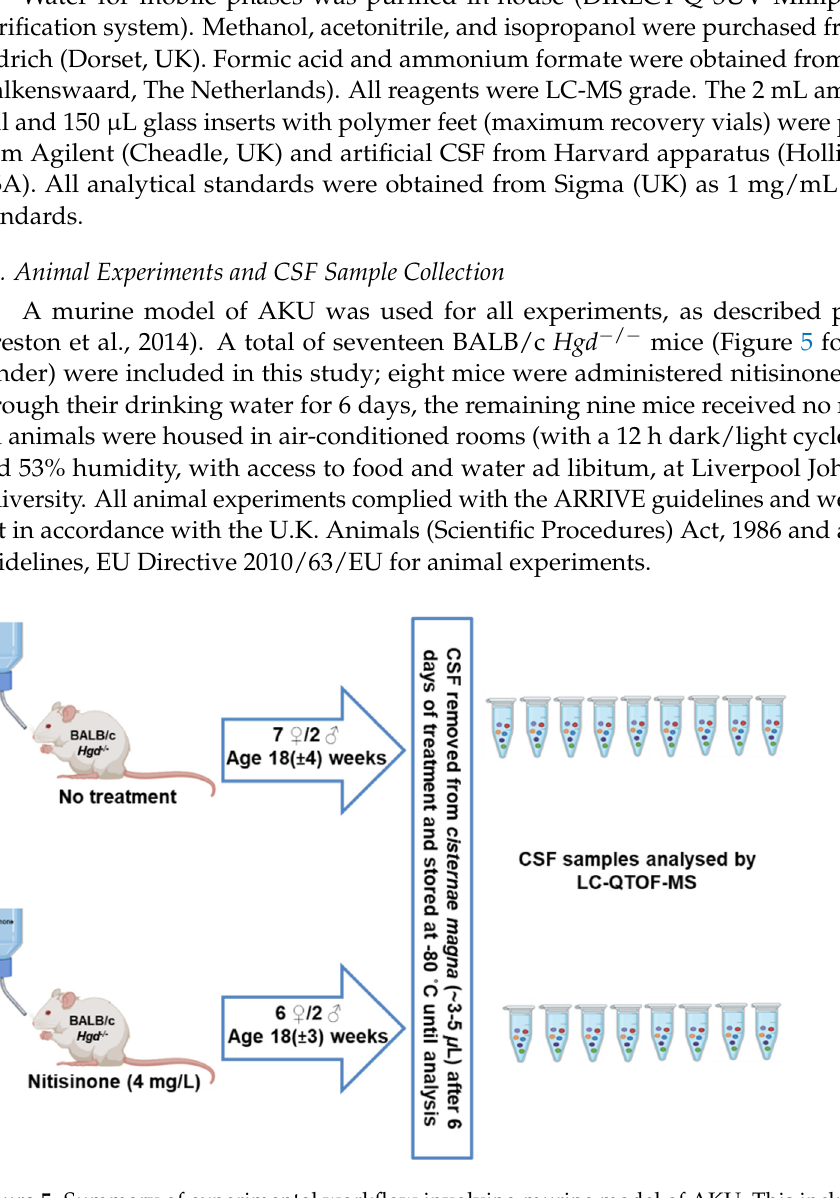
Figure 5. Summary of experimental workflow involving murine model of AKU. This includes mouse gender ( ♂ —male; ♀ —female) and mean age (±standard deviation), treatment groupings, and sample collection and storage. Mass spectrometry analysis was performed in positive and negative polarities in all samples collected, except one sample in the negative polarity, due to a low sample volume (i.e., n = 7/8 samples were analysed in the nitisinone group).